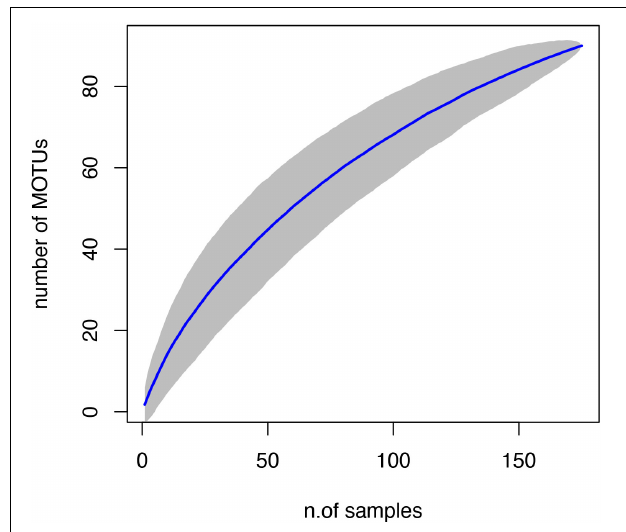
FIGURE 2 | Species accumulation curve with 95% confidence intervals (gray area) for the 172 samples (considering 2 PCR replicates per sample).